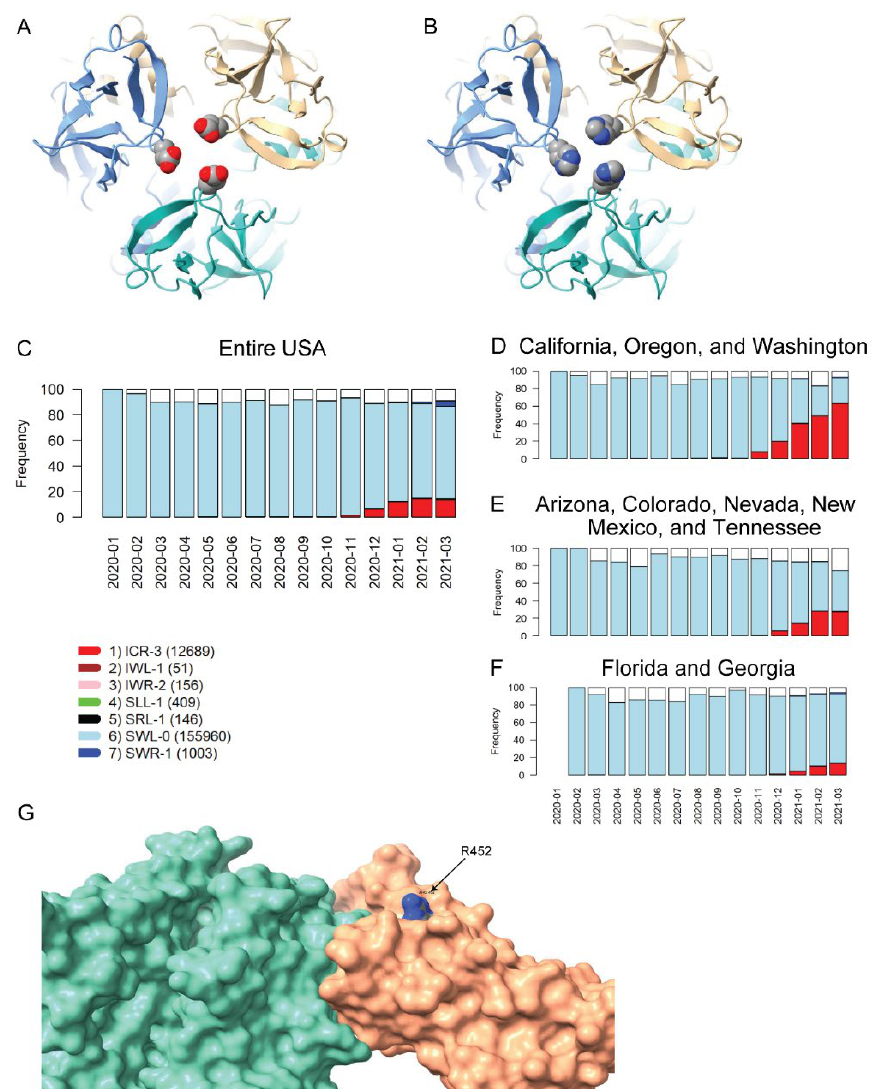
Figure 3. Homology modeling of Spike mutations and haplotypic polymorphisms over time of the S13-W152-L452 VRV-haplotype. ( A , B ) Modeled structure of the Spike protein trimer with ( A ) D1118 or ( B ) H1118 (homology-modelled using PDB entry 7KRS as the template structure). Spike protein monomers are displayed in blue, salmon, and aquamarine; aspartic acid and histidine residues are rendered as CPK images. ( C – F ) Frequencies over time for seven commonly observed haplotypic polymorphisms of the S13-W152-L452 VRV-haplotype, out of its polymorphisms in the US. Only haplotypic polymorphisms with at least 50 observations are included. Nomenclature is as follows: The first three letters designate the amino acids present at positions 13, 152, and 452, respectively; the number after the hyphen designates the number of amino acids at these three positions that do not match their reference strain equivalents. Numbers of sequences harboring each S13-W152-L452 haplotypic polymorphism (across the entire USA) are shown in parentheses. Frequencies of seven common S13-W152-L452 VRV-haplotypic polymorphisms ( C ) in the entire US; ( D ) in California, Oregon, and Washington combined; ( E ) in Arizona, Colorado, Nevada, New Mexico, and Tennessee combined; and ( F ) in Florida and Georgia combined. ( G ) Homology-modeled complex of the receptor-binding domain of the Spike protein (salmon), harboring the L452R mutation, bound to the angiotensin-converting enzyme 2 (ACE2) receptor (aquamarine). Within the R452 residue, nitrogen atoms are shown in blue and carbon atoms are shown in